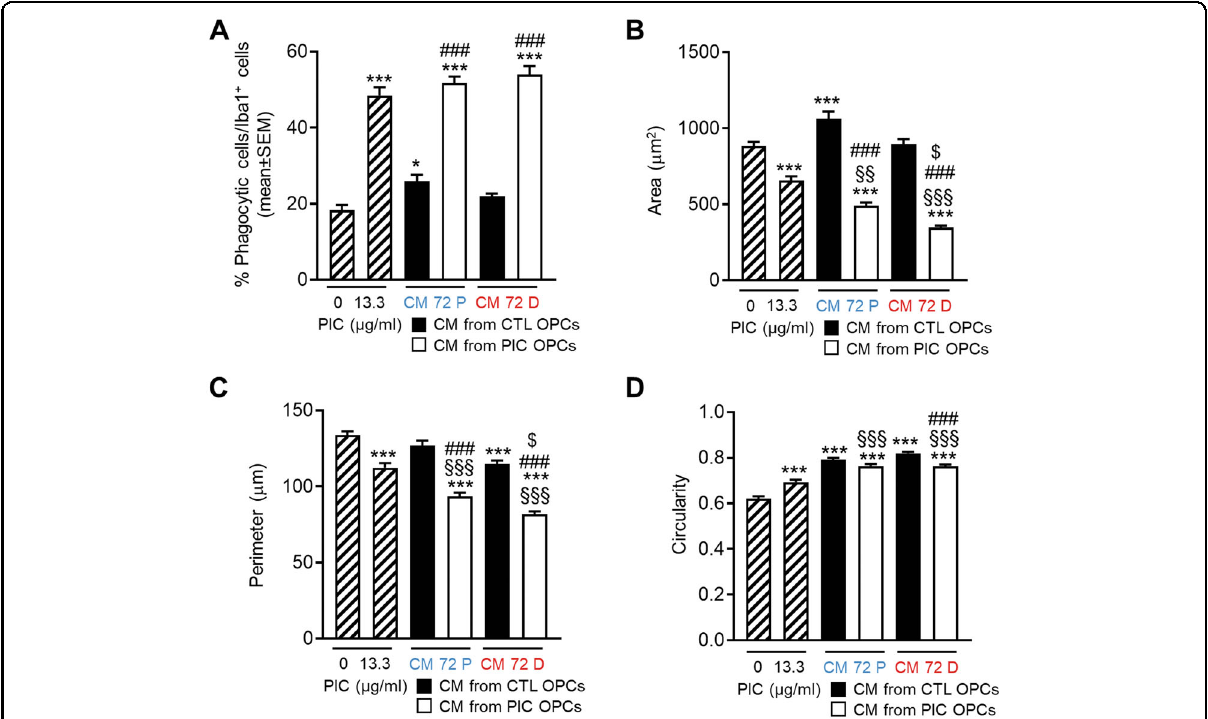
Fig. 8 Conditional medium (CM) from proliferating and differentiating OLs regulates microglia phagocytosis and cell morphology. A Histograms reported the percentage of phagocytic cells determined as: number of cell with beads/number of total Iba1 + cells. Results are the mean of three independent experiments performed in triplicate ±SEM. B – D Microglial cell morphological changes induced by PIC or conditional medium considering cells area ( B ), cells perimeter ( C ), and cells circularity ( D ). Data are the mean of at least 250 cells/condition ±SEM. All comparisons were performed using One-way Anova followed by Bonferroni ’ s multiple comparison test. * P < 0.05 and *** P < 0.001 vs CTRL, ### P < 0,001 CM from CTRL OPCs vs CM from PIC OPCs, §§§ P < 0.001 and §§ P < 0.01 vs PIC, $ P < 0.05 PIC CM P vs PIC